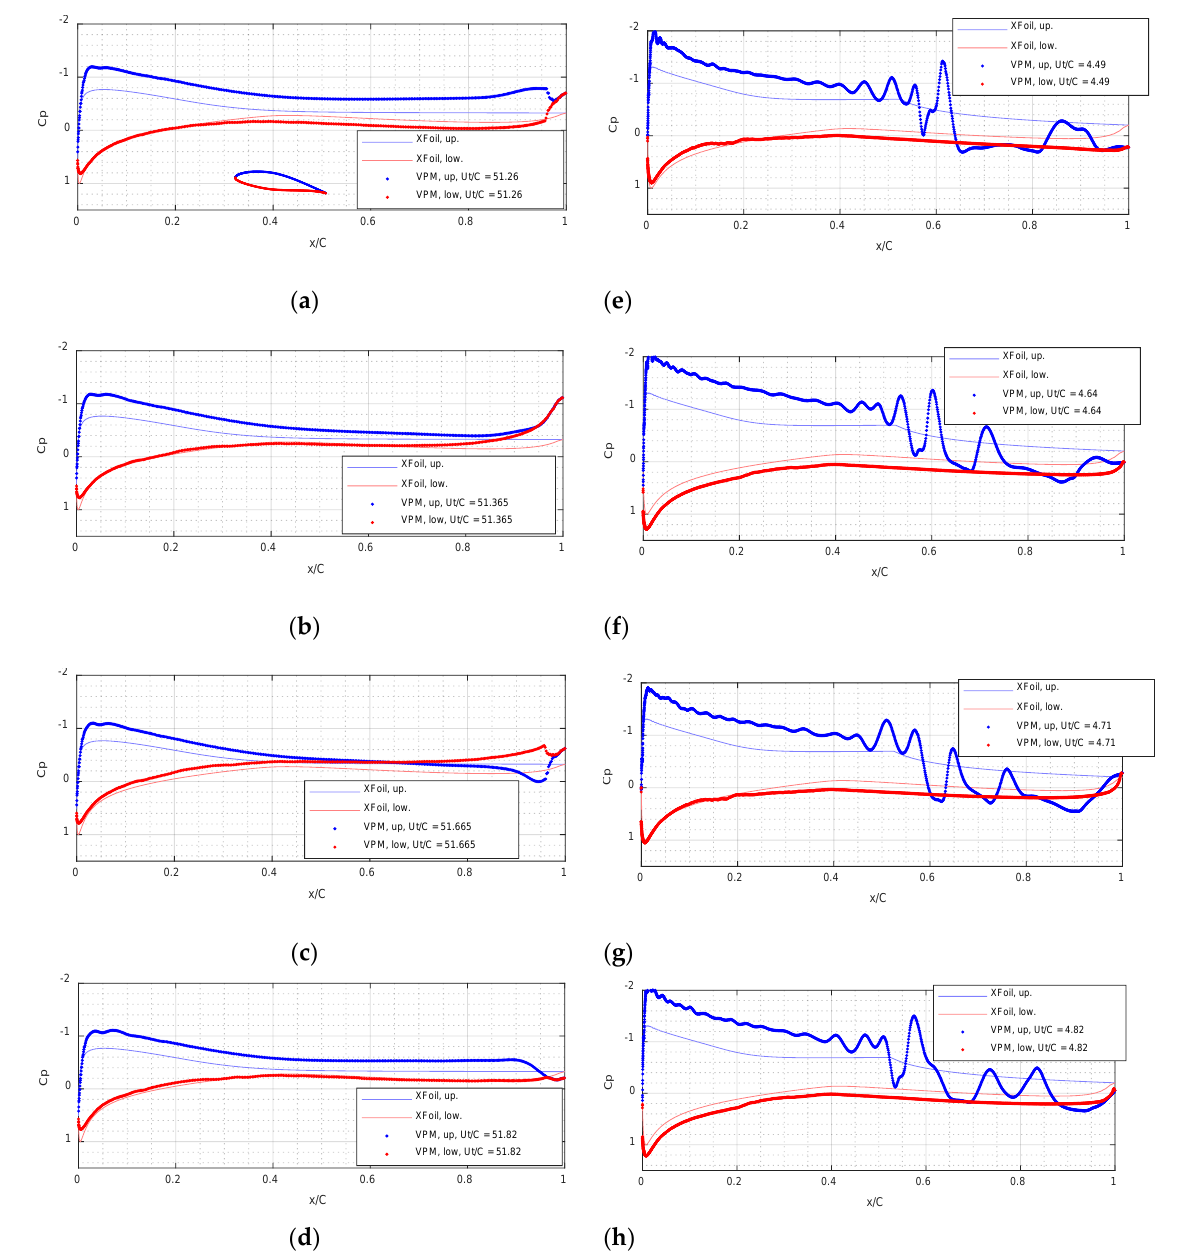
Figure 9. Instantaneous distribution of surface pressure coefficient of NACA64 airfoil. For α = 10°, Rec = 4000, Ut / C = ( a ) 51.26, ( b ) 51.365, ( c ) 51.665, and ( d ) 51.82. For Rec = 60,000, Ut / C = ( e ) 4.49, ( f ) 4.64, ( g ) 4.71, and ( h ) 4.82. Note that the blue-colored symbols represent the upper surface while the red represents the lower surface.